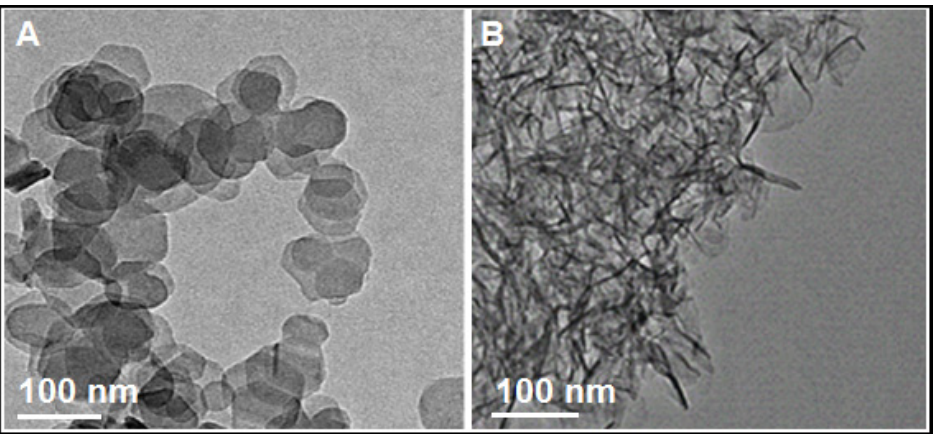
Figure 4. SEM images of lab-prepared CoMgAl LDHs [6]. Copyright 2018, reproduced with permis- sion from the American Chemical Society.